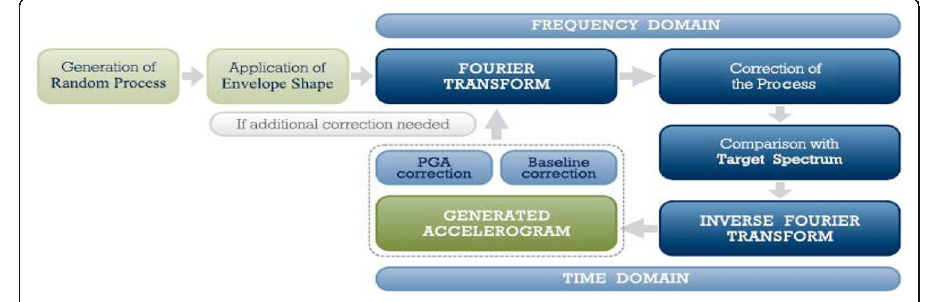
Fig. 9 Real accelerogram adjustment calculation schematic